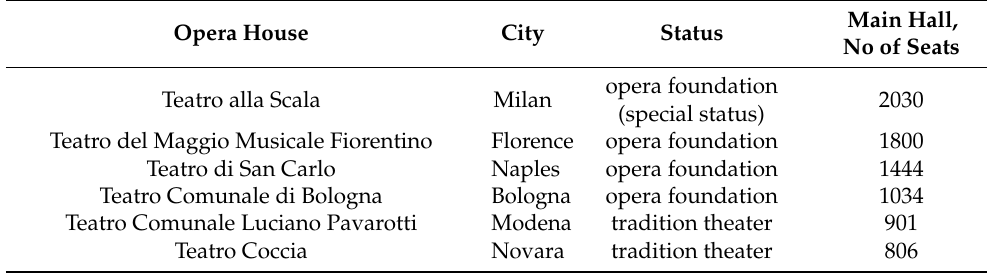
Table 1. Basic information on the six opera